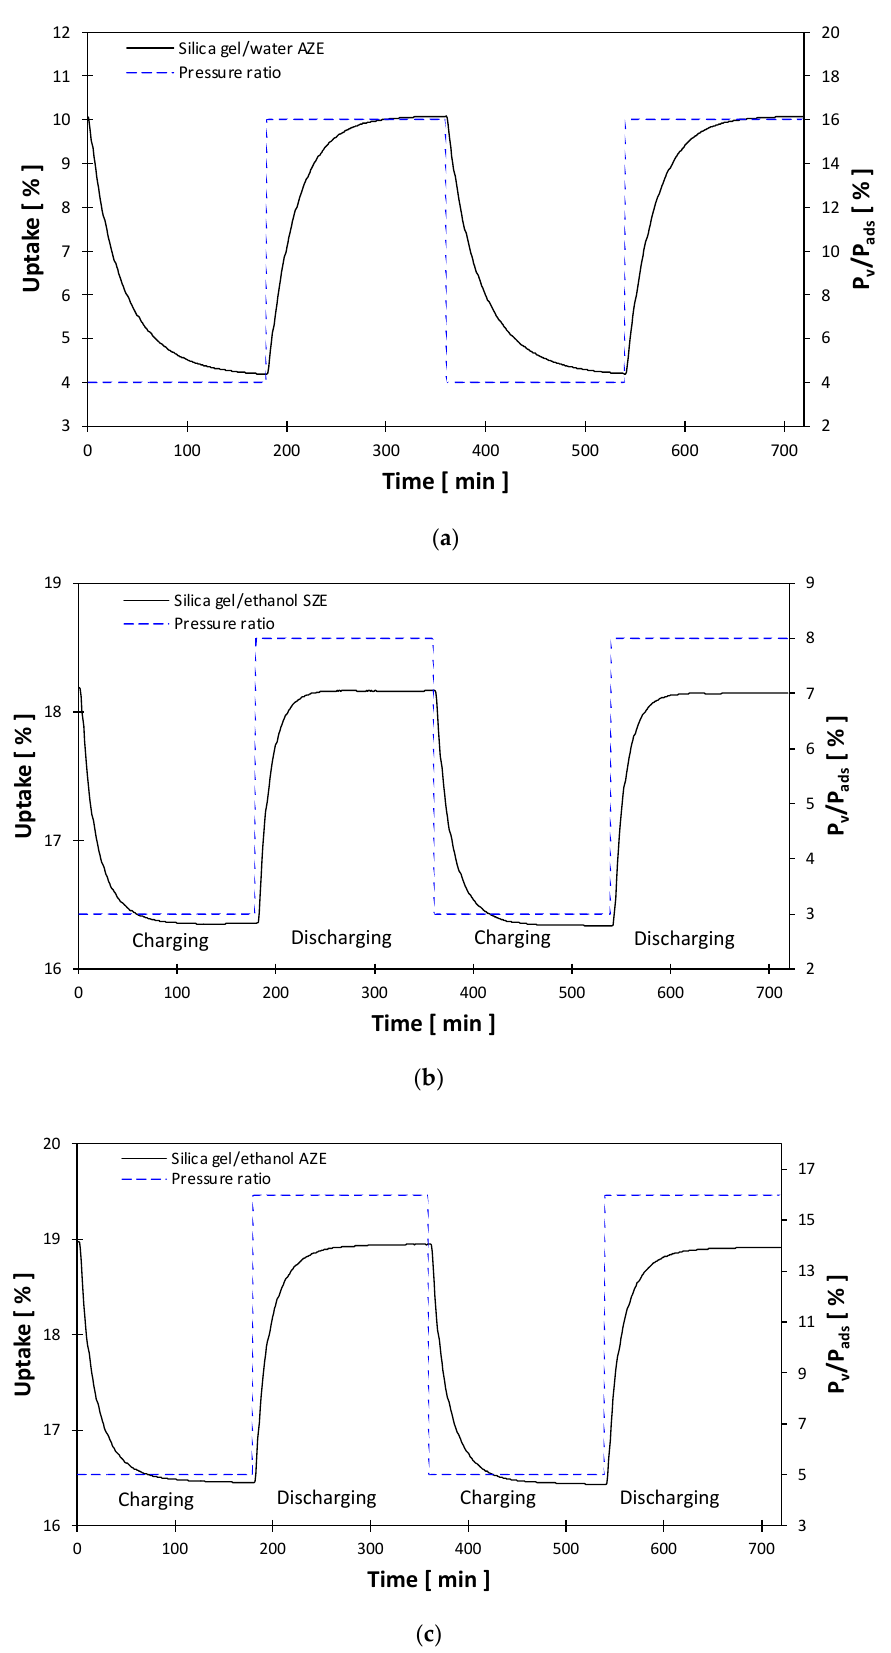
Figure 6. Heat chagrining/discharging cycles for ( a ) silica gel/water AZE, ( b ) silica gel/ethanol AZE and ( c ) silica gel/ethanol SZE.